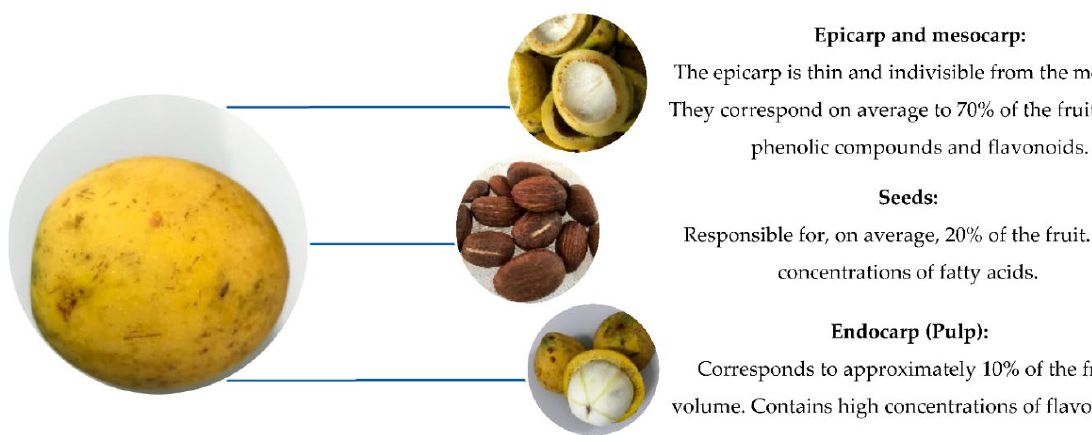
Figure 1. Contribution of bacuri ( Platonia insignis) components to fruit volume.